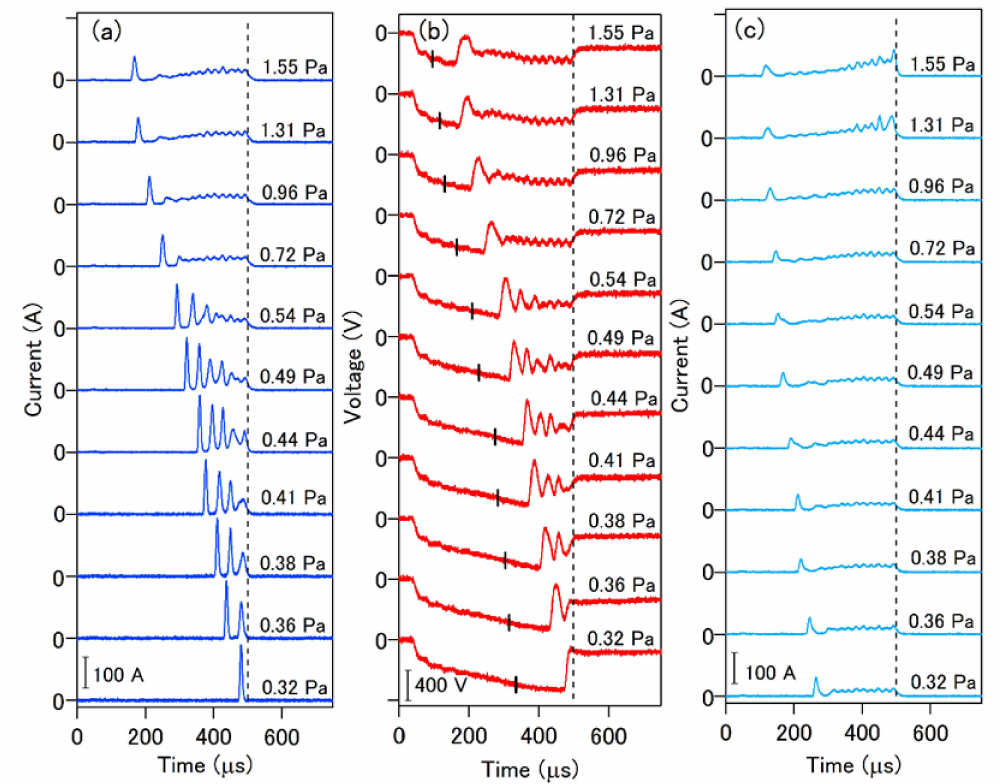
Figure 3. ( a ) Discharge current waveforms (blue lines) and ( b ) discharge voltage waveforms (red lines) in modulated pulsed power magnetron sputtering (MPPMS) for the working pressure in the range of 0.32 to 1.55 Pa. The black dashed lines indicate the cutoff time of pulsed power, which is output from a high-power pulsed generator. The short black lines on the discharge current waveforms indicate the breakdown voltage V s as a function of argon pressure. ( c ) Discharge current waveforms (light blue lines) for MPPMS with an anode ring, as shown in Figure